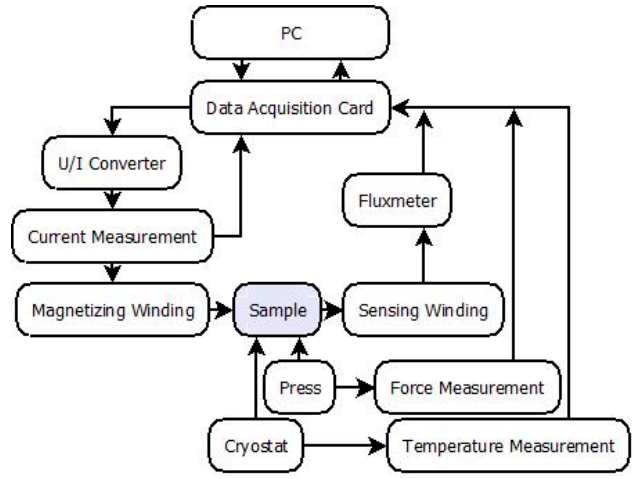
Figure 3. Schematic diagram of the developed Ferrograph system [17].